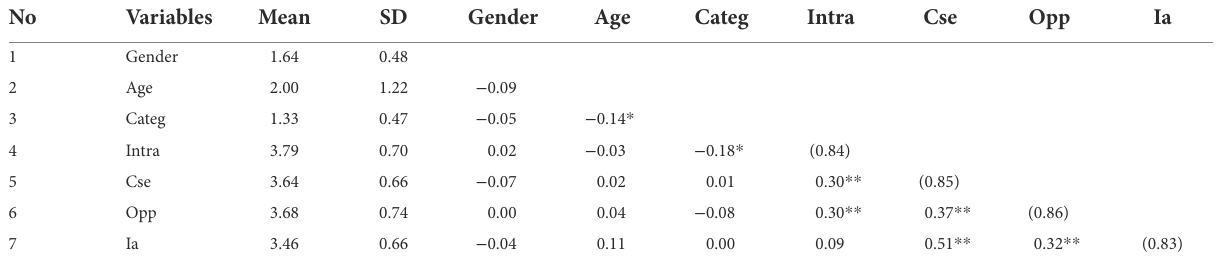
TABLE 3 Means, standard deviations, correlations, and square roots of AVE in